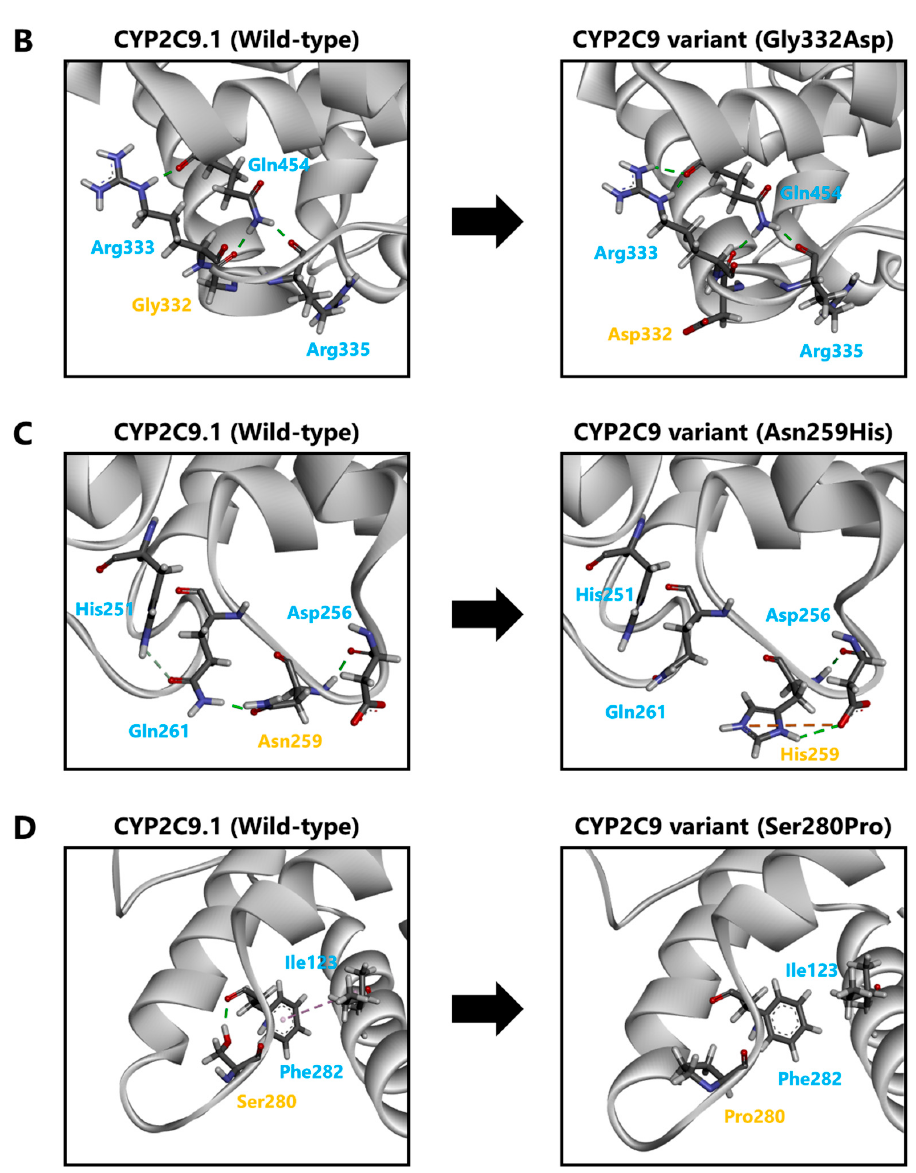
Figure 5. Diagram pairs showing the partial crystal structure of CYP2C9.1 (left image) and CYP2C9 variants (right image). Pink line: hydrophobic interactions. Green line: conventional hydrogen bonds. Gray line: carbon-hydrogen bonds. Orange line: electrostatic interaction.